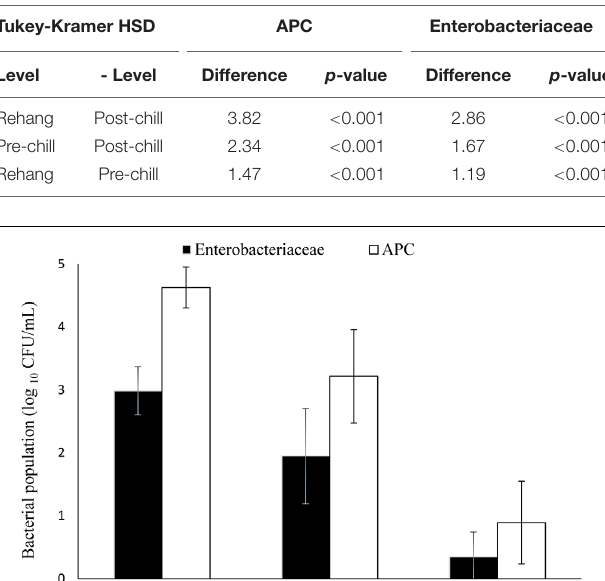
TABLE 2 | Tukey-Kramer HSD for all plant microbial counts log CFU/mL.